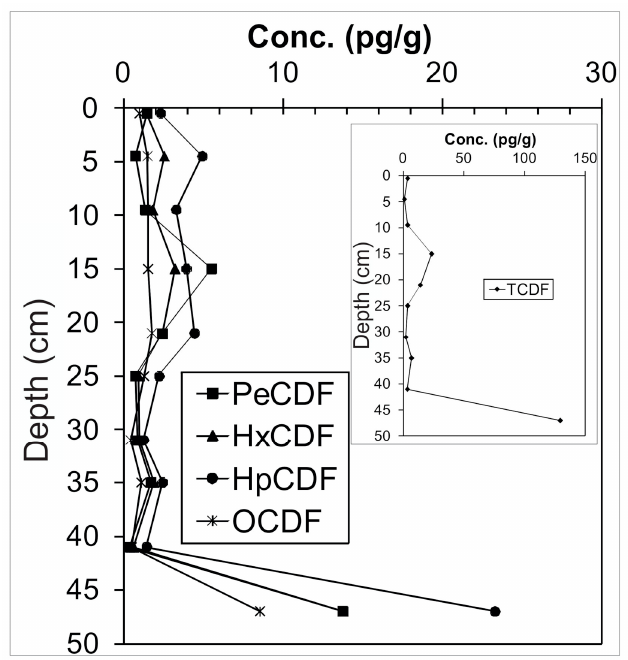
Figure 8. Downcore variation in furan homologue concentration for bulk sediment samples. Inset shows TCDF, which is present at significantly higher concentrations than the other homologues. Minerals 2019 , 9 , x FOR PEER REVIEW 14 of 34